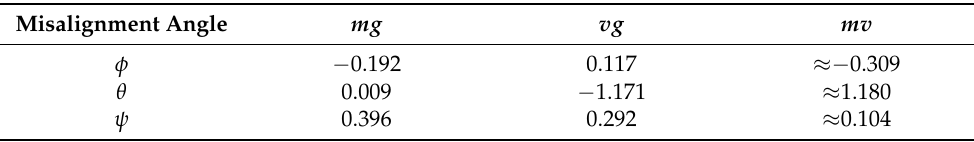
Table 5. Misalignment angles computed from the identified m - g and v - g misalignments in Sections 3 and 4 (see Tables 1 and 3). Results expressed in degrees.